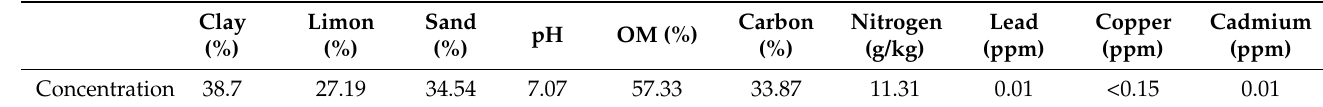
Table 1. Physico-chemical characteristics of the substrate used in this study.